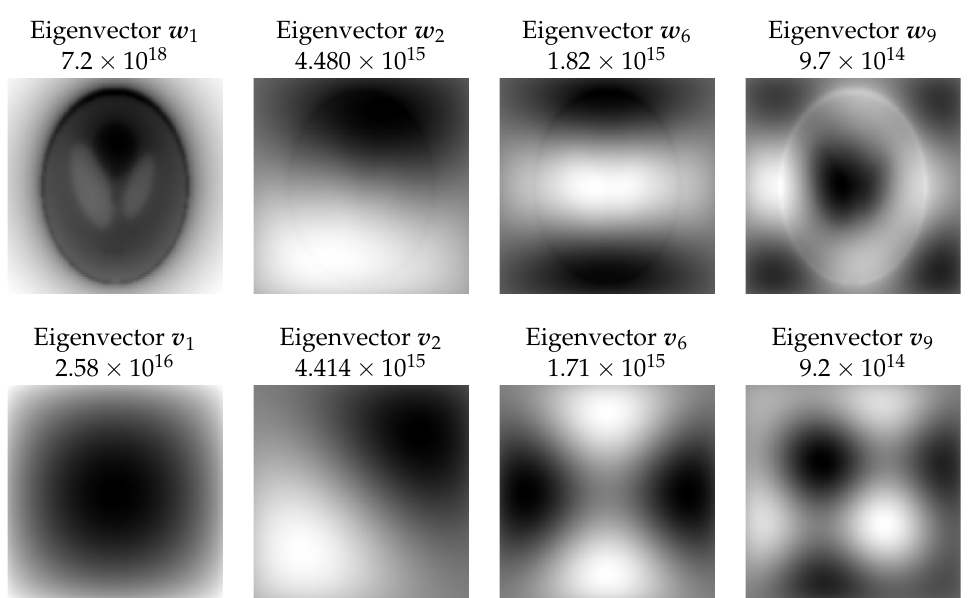
Figure 11. Eigenvectors of uncentered AS w i and centered AS v i , i = 1,2,6,9 and their corresponding eigenvalues, noise level